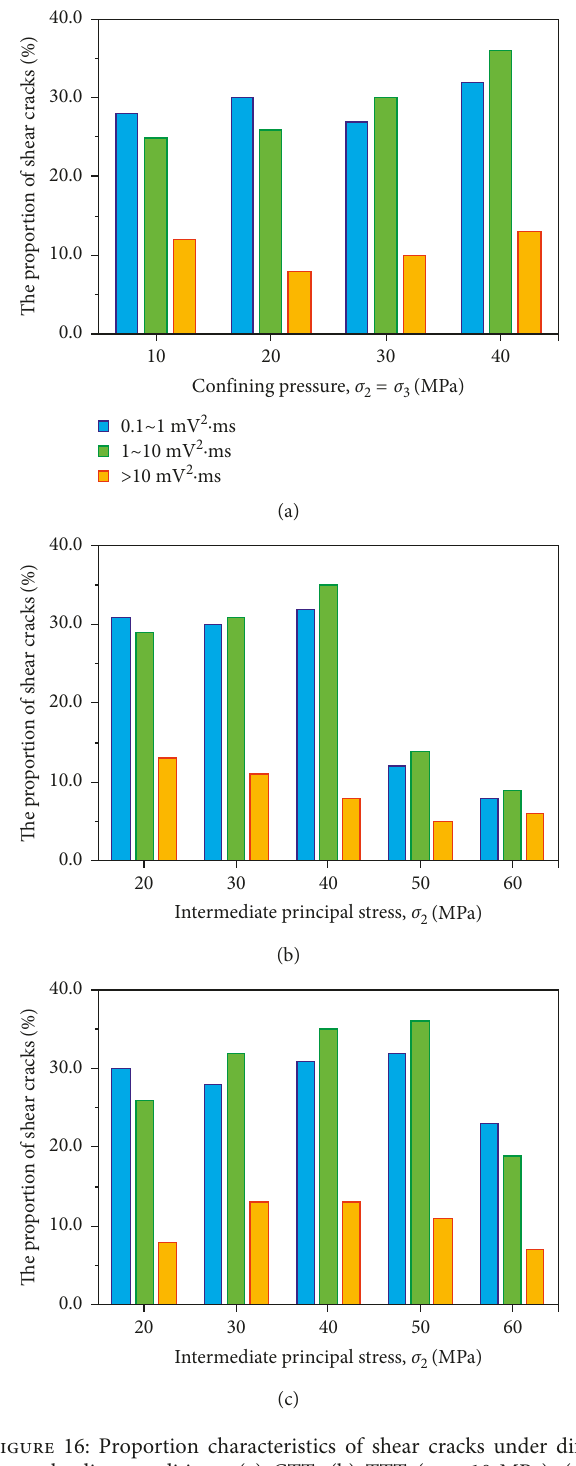
10 MPa); (c) (cid:31)